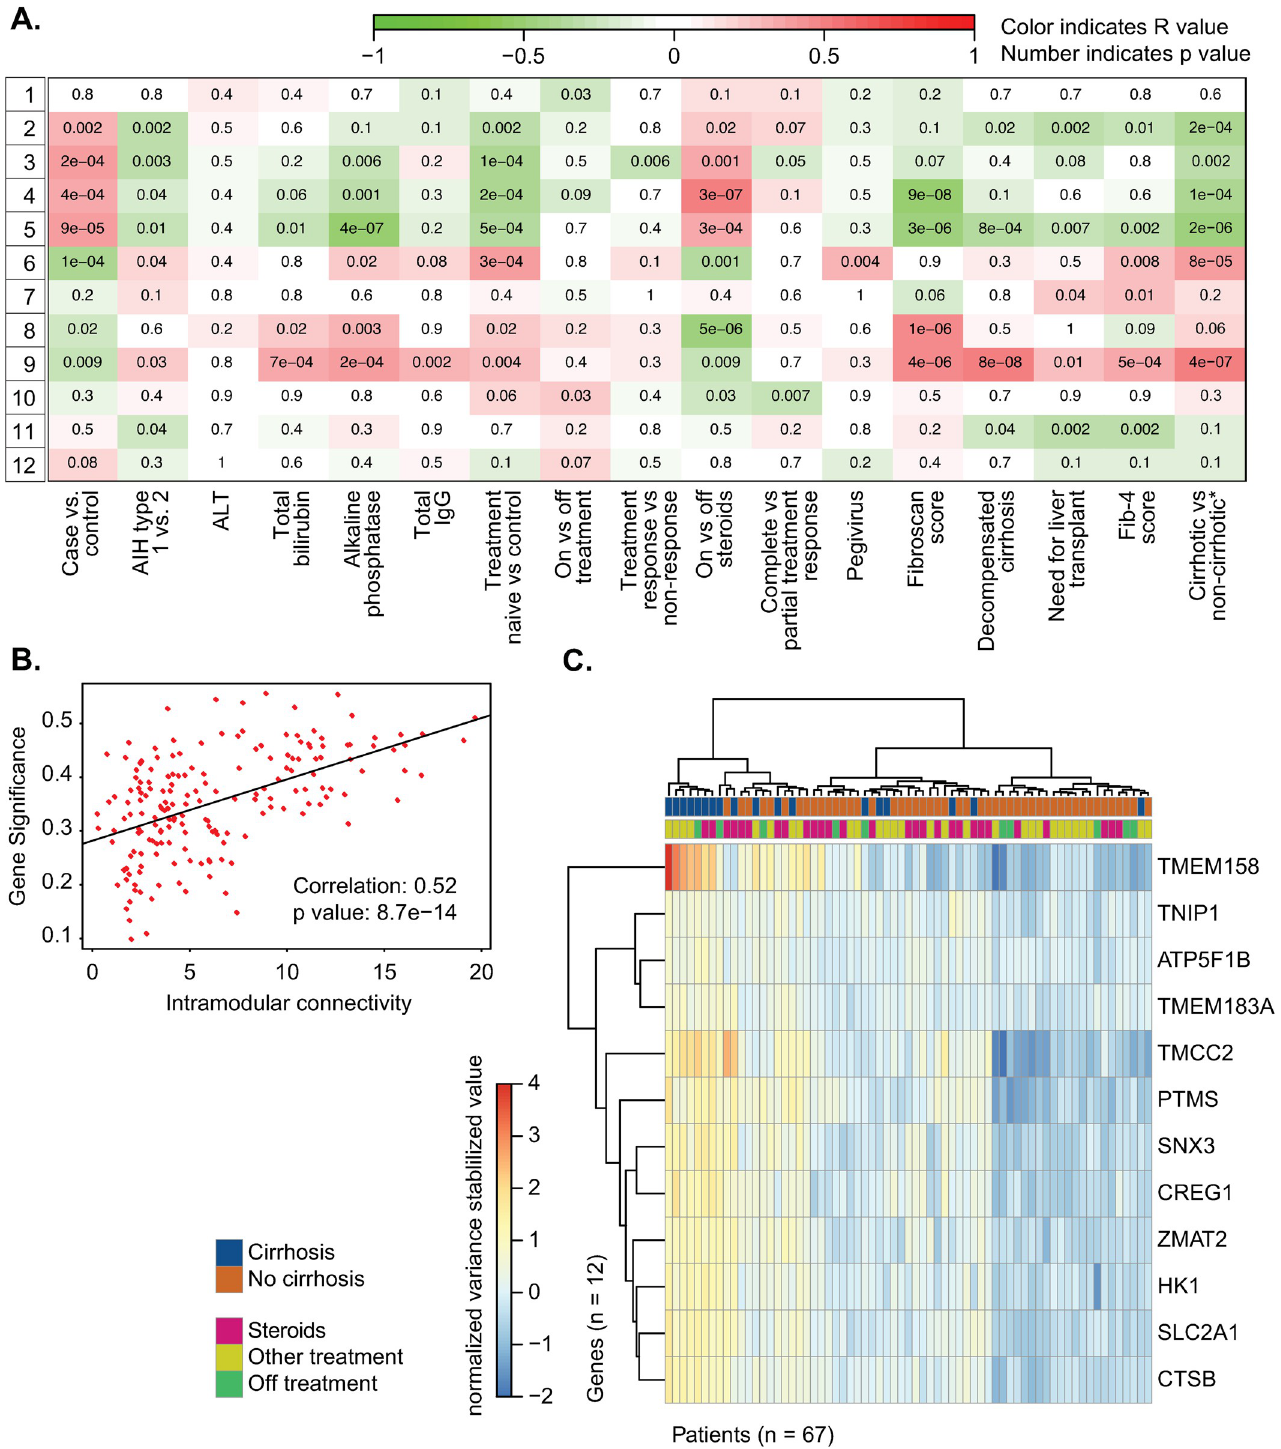
PLOS ONE | https://doi.org/10.1371/journal.pone.0264307 March 21,